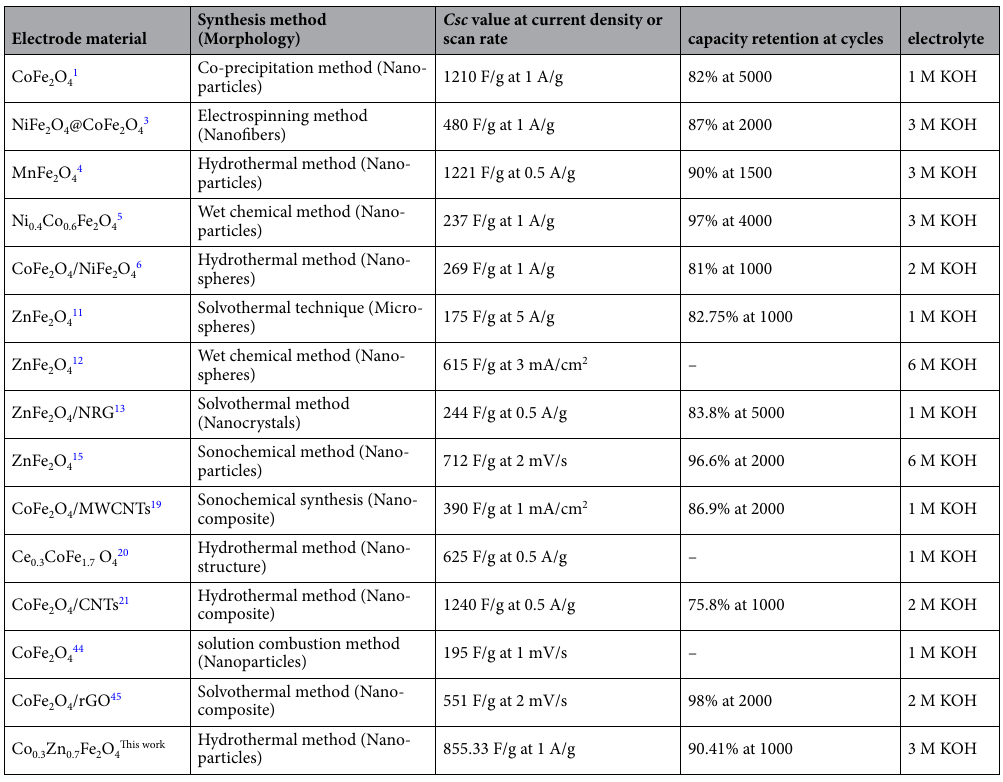
Table 3. Electrochemical properties of electrodes fabricated from various spinel TMOs (AB 2 O 4 ) and synthesized